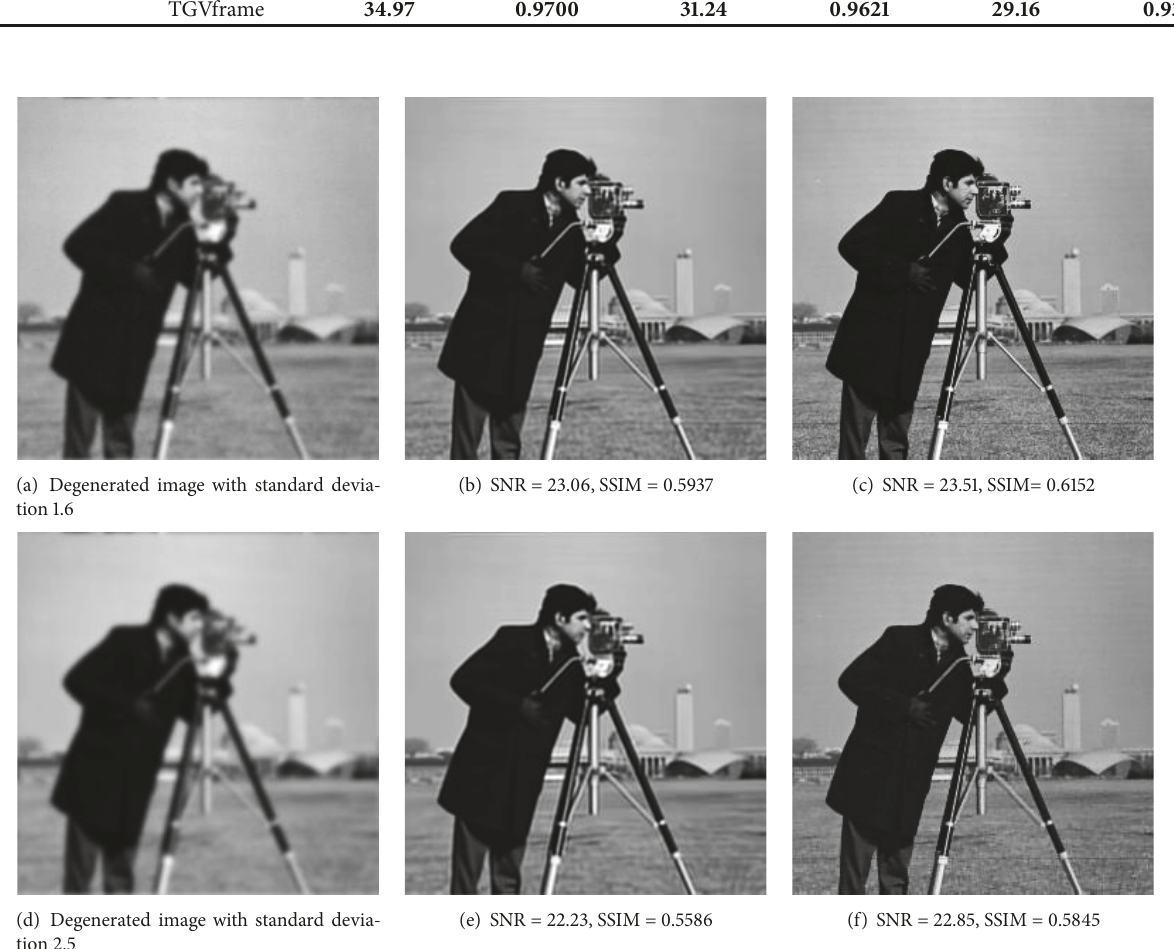
Figure 11: The results compared with BM3D. (a) Blurred and noisy image; (b) image recovered by BM3D; (c) image recovered by our method; (d) blurred and noisy image; (e) image recovered by BM3D; (f) image recovered by our